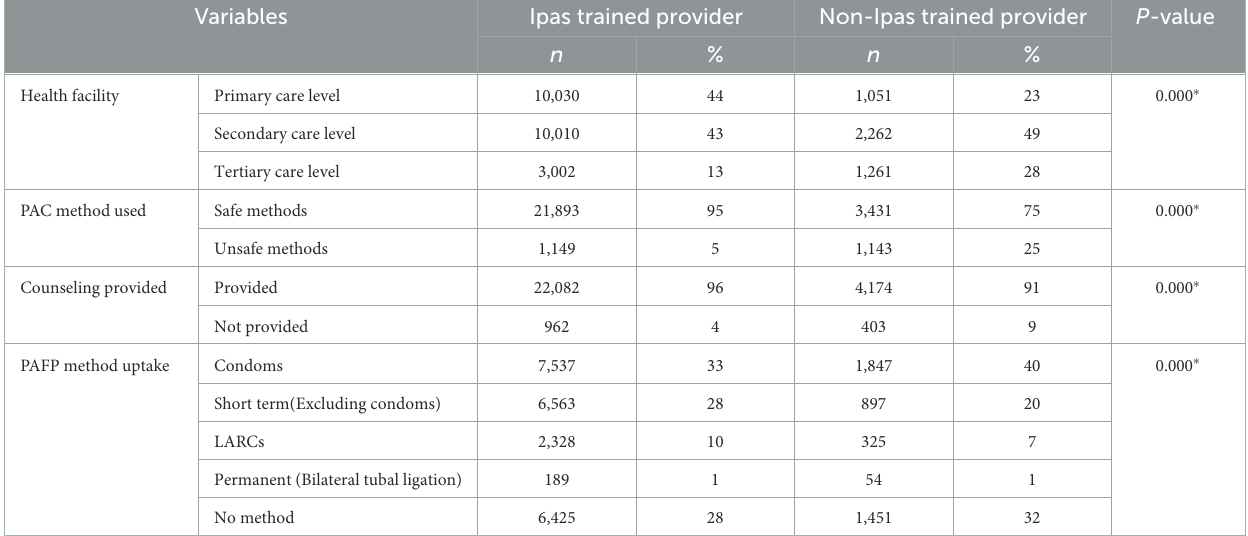
TABLE 3 Inferential analysis between Ipas-trained and non-Ipas-trained providers.